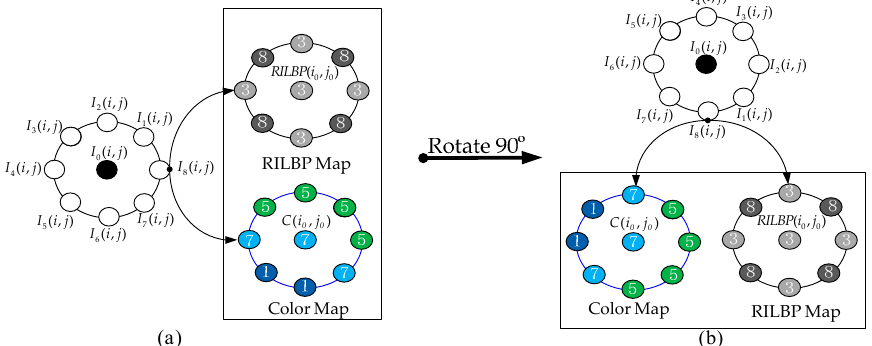
Figure 5. Illustration of the rotation invariance of the rotation-invariant local parallel cross pattern ( RILPCP).